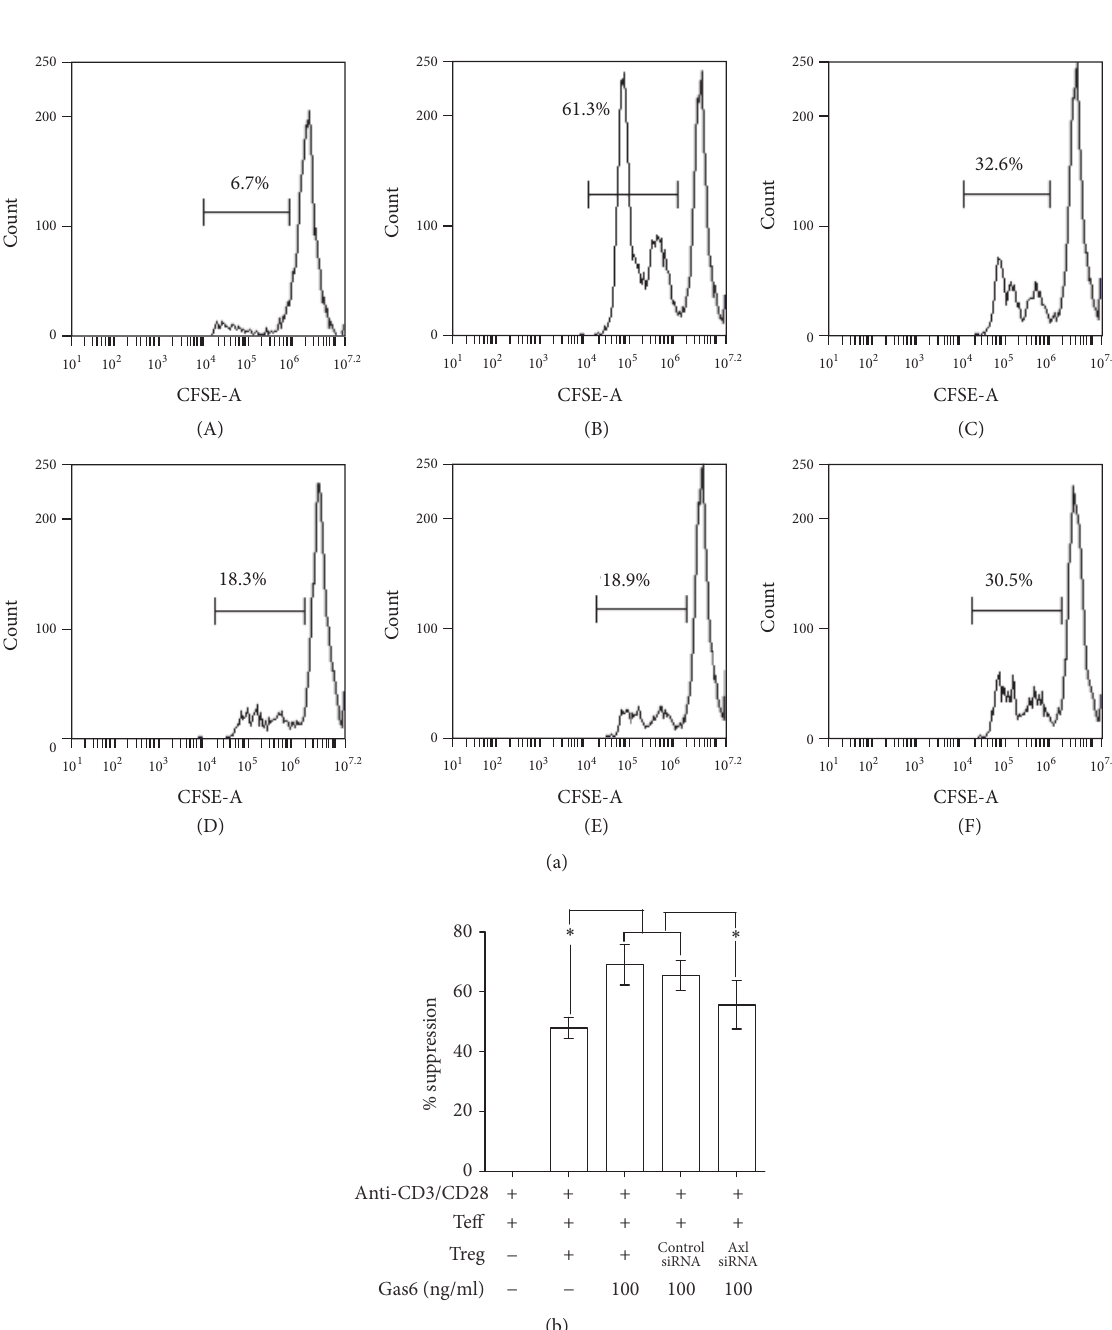
Figure 7: Gas6 modulates the suppressive function of Tregs mainly through Axl receptor. Axl knockdown Tregs were pretreated with 100ng/ml rmGas6 for 24 h and then mixed with CD4 + CD25 − T cells in presence of anti-CD3/CD28 Abs. After 72 h, the suppressive function of CD4 + CD25 + T cells was determined by CFSE assay (a and b) ( 𝑛 = 4 /group). (A) CD4 + CD25 − T cells alone. (B) CD4 + CD25 − T cells were stimulated with a combination of soluble anti-CD3 and anti-CD28 antibodies. (C) CD4 + CD25 + Tregs and (D) rmGas6-pretreated Tregs were mixed with CFSE-labeled CD4 + CD25 − T cells at a ratio of 1 :1 in the presence of anti-CD3 and anti-CD28 antibodies. (E) siRNA-control and (F) siRNA-Axl transfected CD4 + CD25 + Tregs pretreated with Gas6 were cocultured with CFSE-labeled CD4 + CD25 − T cells. ∗ 𝑃 < 0.05